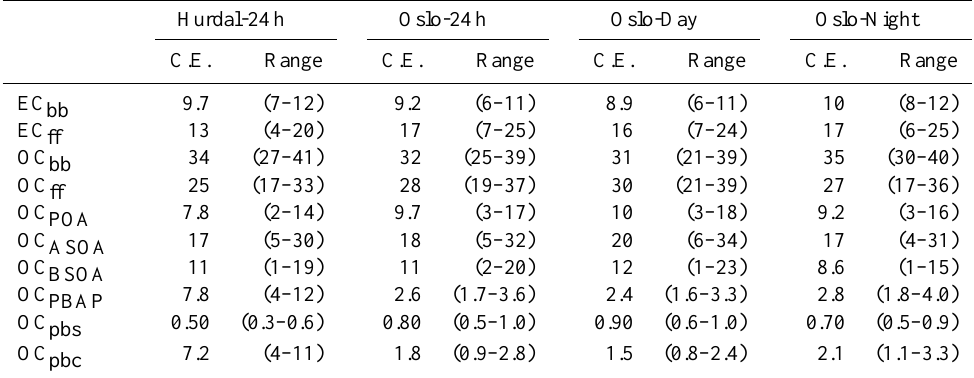
Table 7. Calculated percentage contributions to total carbon from LHS analysis, PM 10 , winter sampling (1–8 March 2007). C.E. is central estimate (50th percentile), range is 10th–90th percentiles of LHS